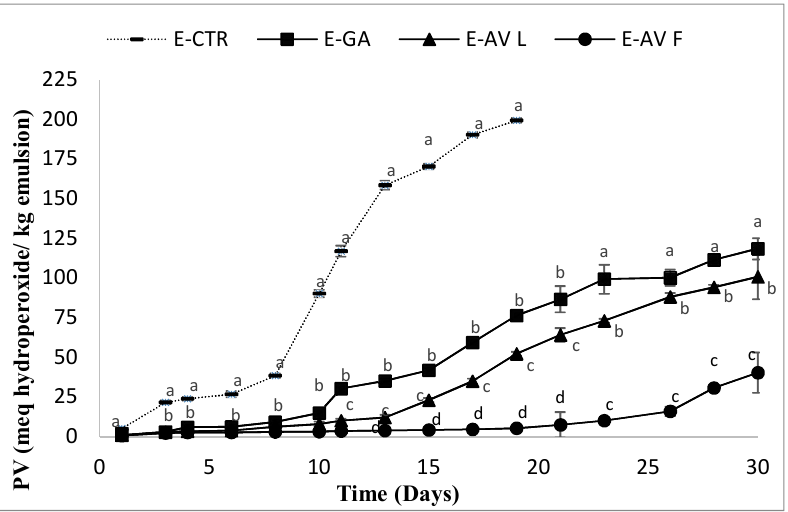
Figure 1. Peroxide values (PV) of emulsions containing A. vulneraria leaf and flower extracts during storage. E-CTR (Control emulsion sample), E-GA (Galic acid emulsion sample), E-AVL ( A. vulneraria leaf emulsion sample), and E-AVF ( A. vulneraria flower emulsion sample). Error bars represent the standard deviation ( n = 3) and different letters in the same day indicate significant difference between samples at p < 0.05.